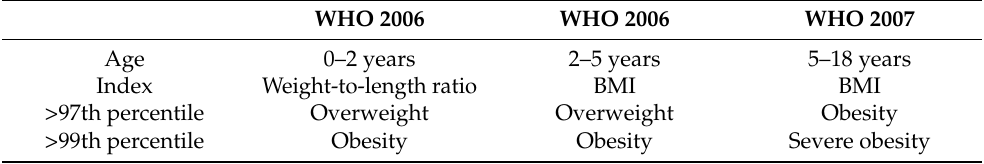
Table 1. Diagnostic criteria to classify obesity according to the World Health